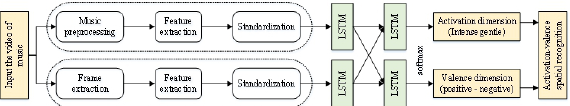
Fig. 2. Multi-modal emotion recognition model architecture for Arousal-Valence